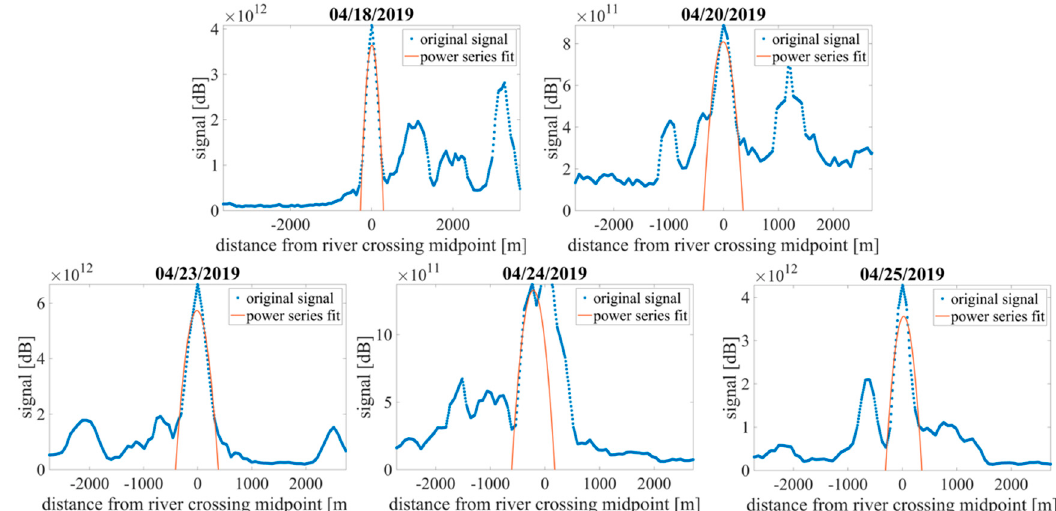
Figure 5. Fitted power series for each of the five April 2019 Pascagoula overpasses, using a threshold of 22% of the peak as the cutoff for the portion of the waveform to be fitted.